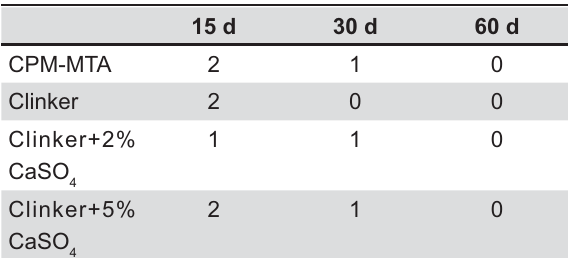
Table 1- (cid:2)(cid:3)(cid:4)(cid:5)(cid:6)(cid:2)(cid:7)(cid:8)(cid:9)(cid:10)(cid:4)(cid:7)(cid:2)(cid:5)(cid:11)(cid:11)(cid:10)(cid:12)(cid:13)(cid:14)(cid:11)(cid:4)(cid:15)(cid:2)(cid:11)(cid:9)(cid:2)(cid:11)(cid:16)(cid:4)(cid:2)(cid:12)(cid:6)(cid:17)(cid:5)(cid:18)(cid:18)(cid:5)(cid:11)(cid:9)(cid:10)(cid:19)(cid:2)(cid:8)(cid:4)(cid:20)(cid:20)(cid:7)(cid:2) (IC) adjacent to implanted material surface in the 15,